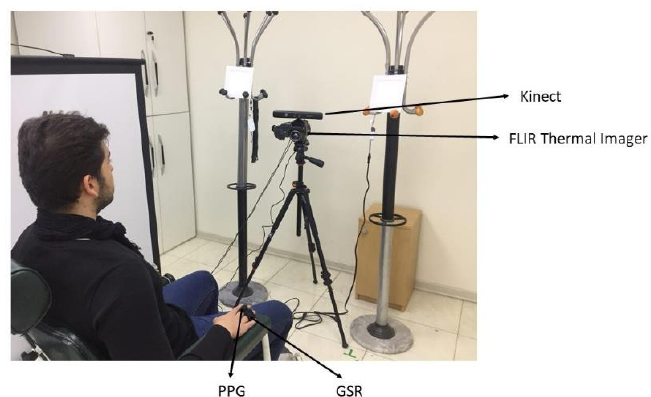
Figure 1. The interview room which benefited from heat and noise isolation. The thermal camera was placed 1.5 m from the face.